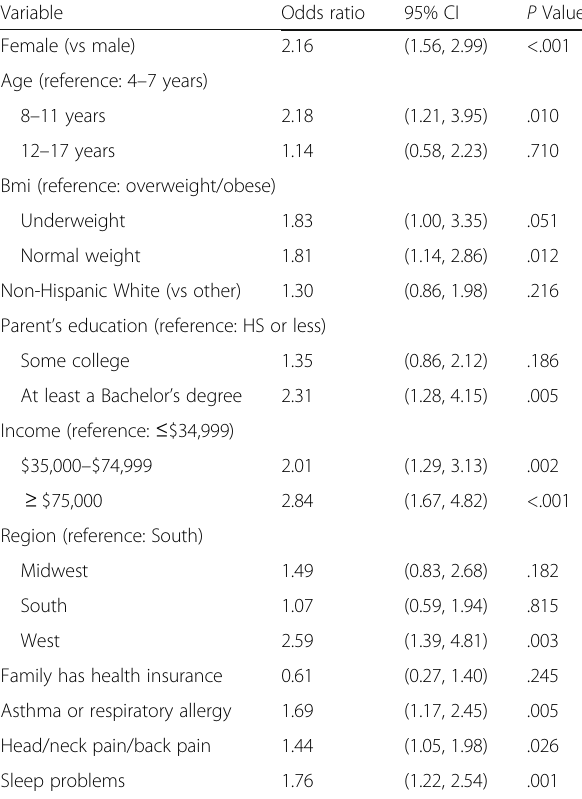
Table 6 Multivariable Survey logistic regression for any CAM use in the last 12 months among n = 1889 children